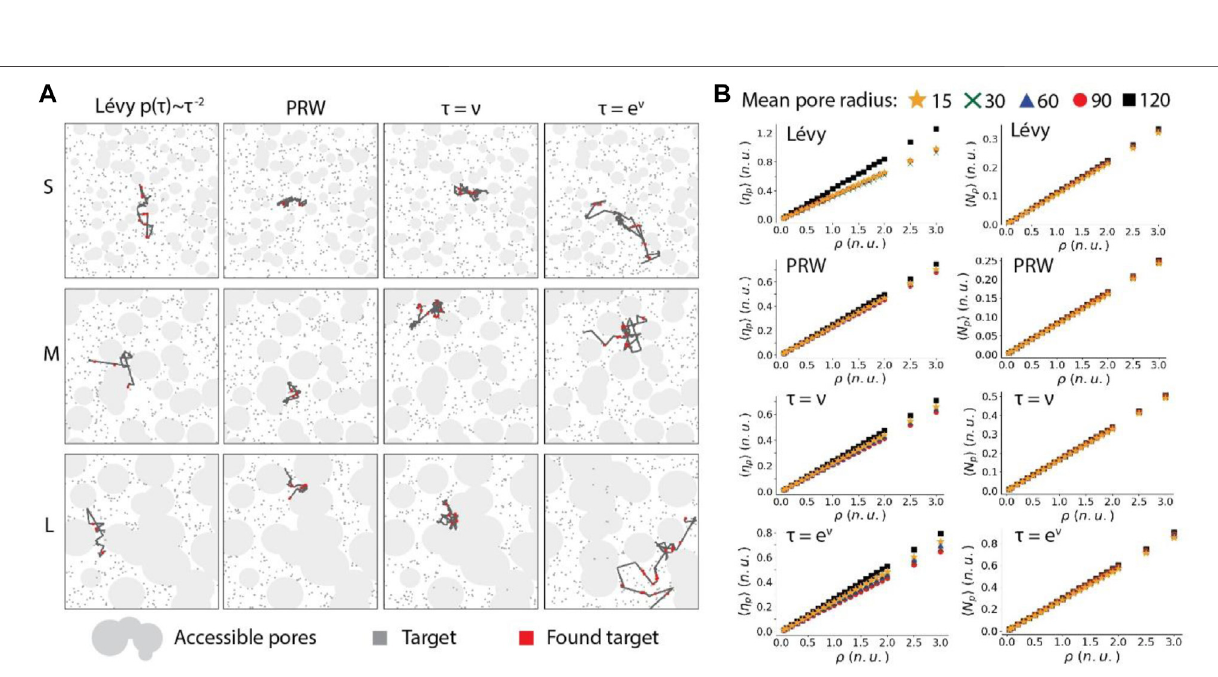
Frontiers in Physics |